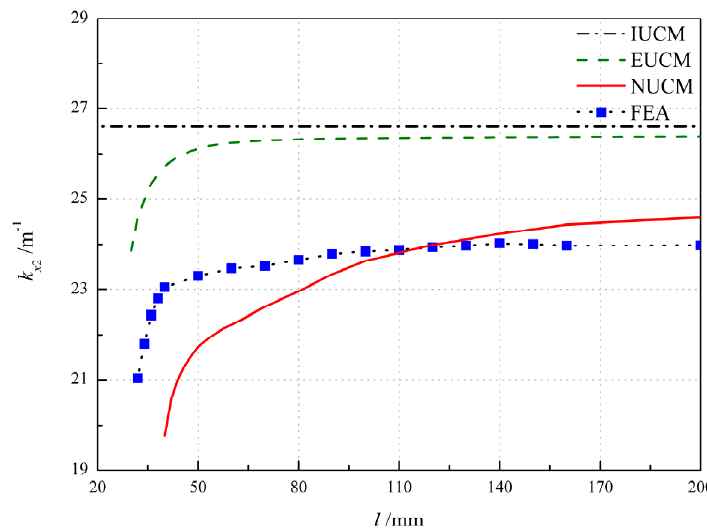
Figure 8. Variation of the principal curvature with respect to the longitudinal length l.